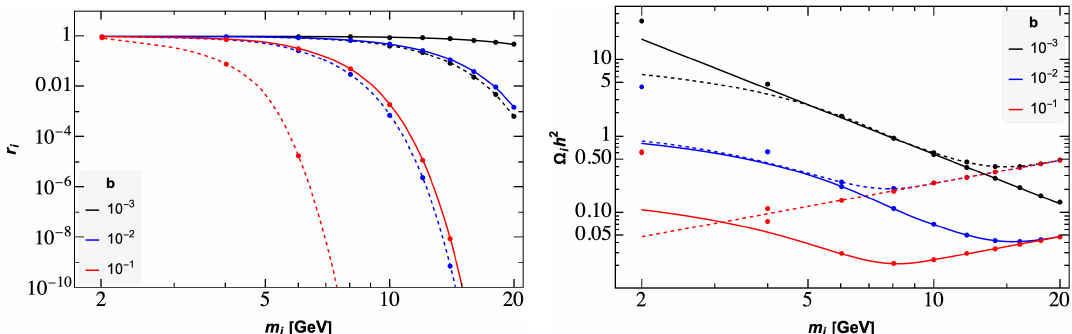
Figure 9 . Asymmetry ratio ( left panel ) and abundance ( right panel ) versus DM mass for different choices of b in the heavy mediator case , without conversions, for N = 10 , with (cid:15) = 1 (dashed) and (cid:15) = 0 . 1